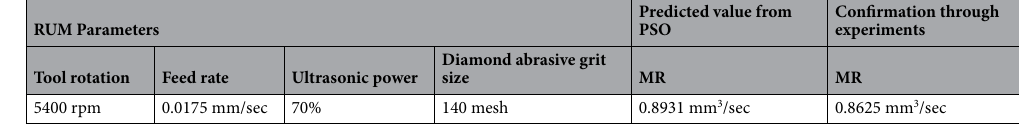
Table 8. Optimum values of RUM conditions for